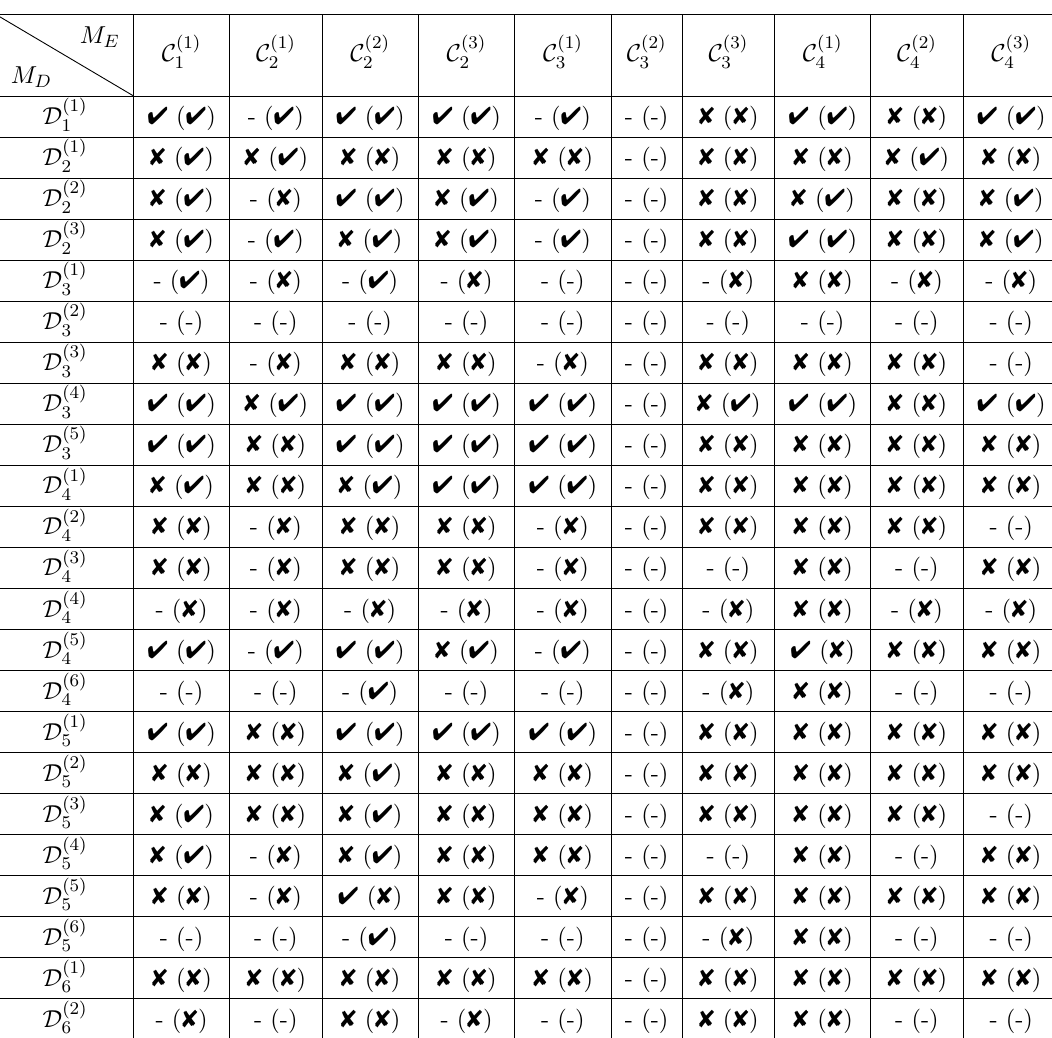
Table 9. The same as in table 8 but for IO neutrino mass